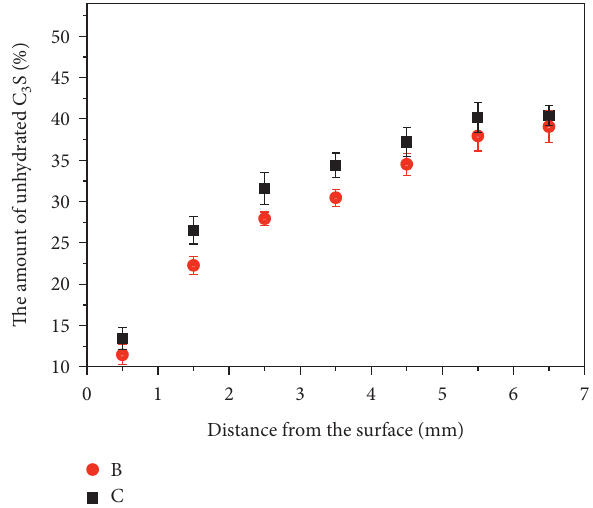
Figure 7: Remaining amount of C surface